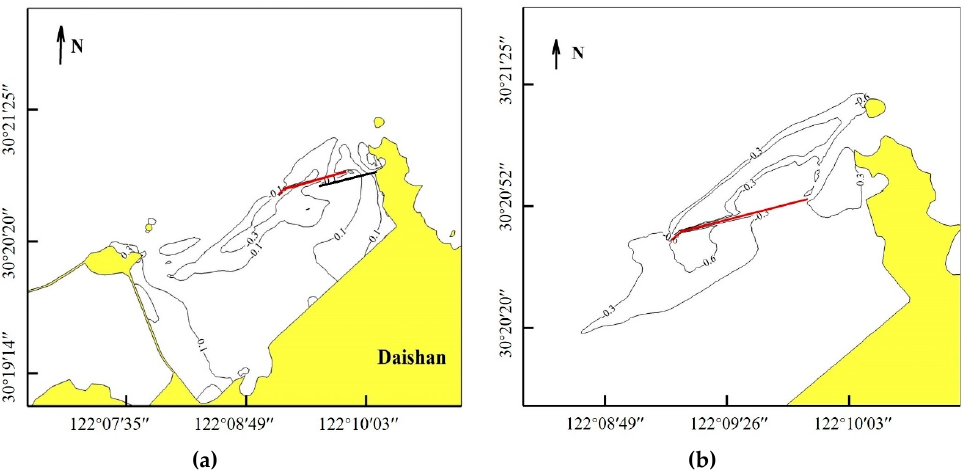
Figure 16. The velocity contour map of flood and ebb tide after plan II implementation(unit: m/s). ( a ) Flood tide, ( b ) Ebb tide.